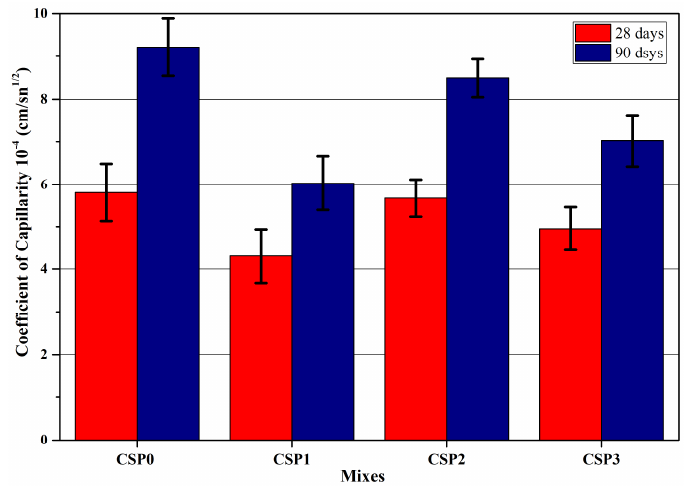
Figure 24. Capillary water absorption values of the control samples.